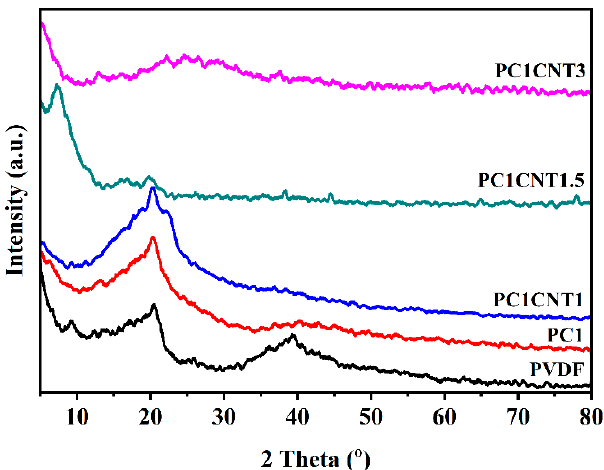
Figure 4. XRD patterns of pure PVDF and PVDF nanocomposites with mono- and bi-nano-fillers prepared by solution cast method, PC1, PC1CNT1, PC1CNT1.5, and PC1CNT3.